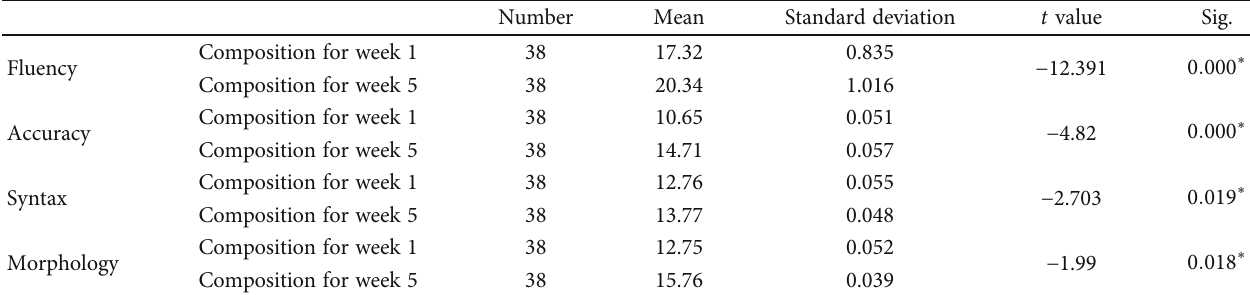
Table 2: Paired sample test: comparison of the fi rst draft and the fi fth draft of the gami fi ed writing